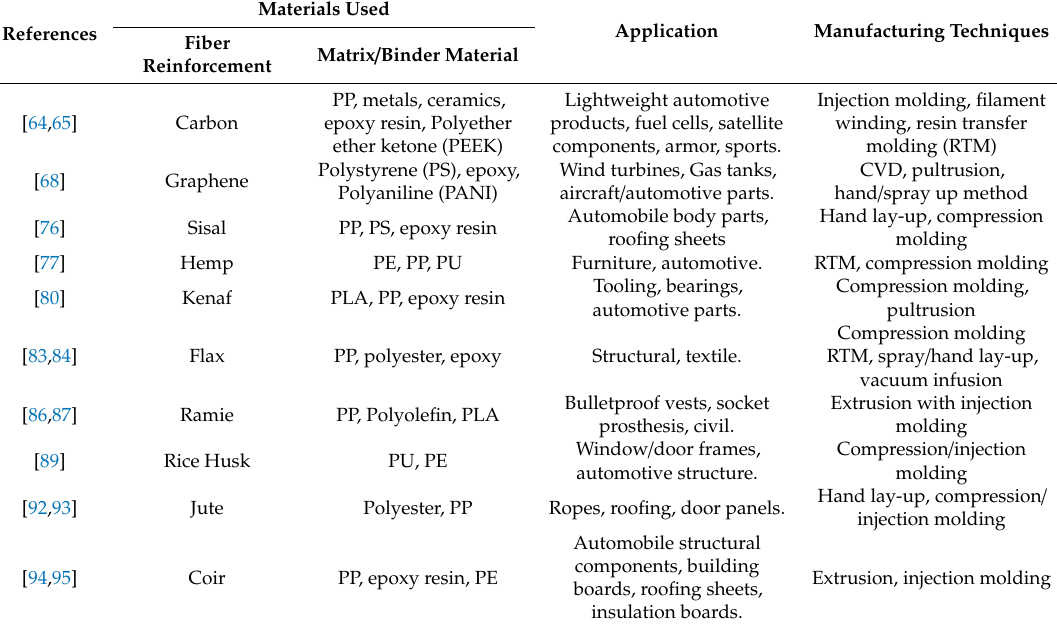
Table 1. Matrix material used for some fibers with their applications and manufacturing